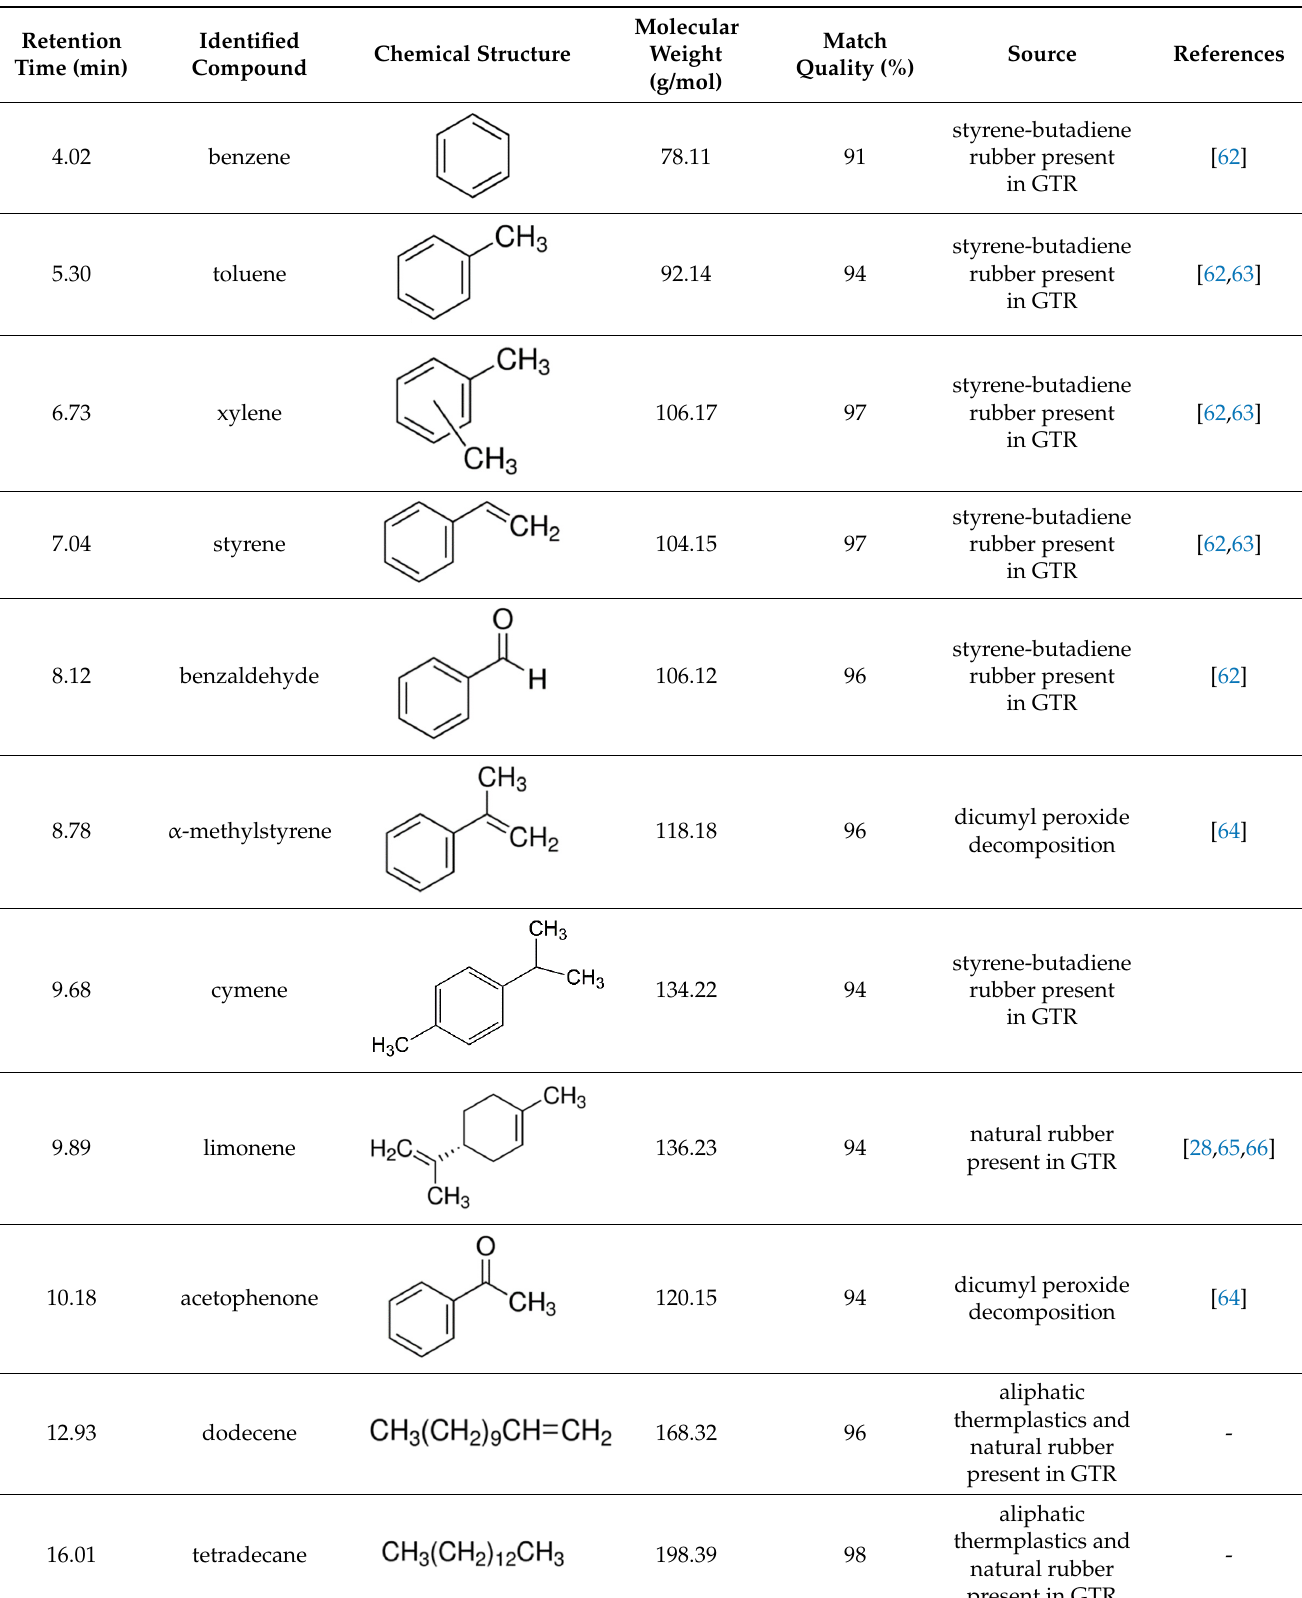
Table 7. Volatile organic compounds emitted during curing of modified GTR determined by GC-MS analysis.